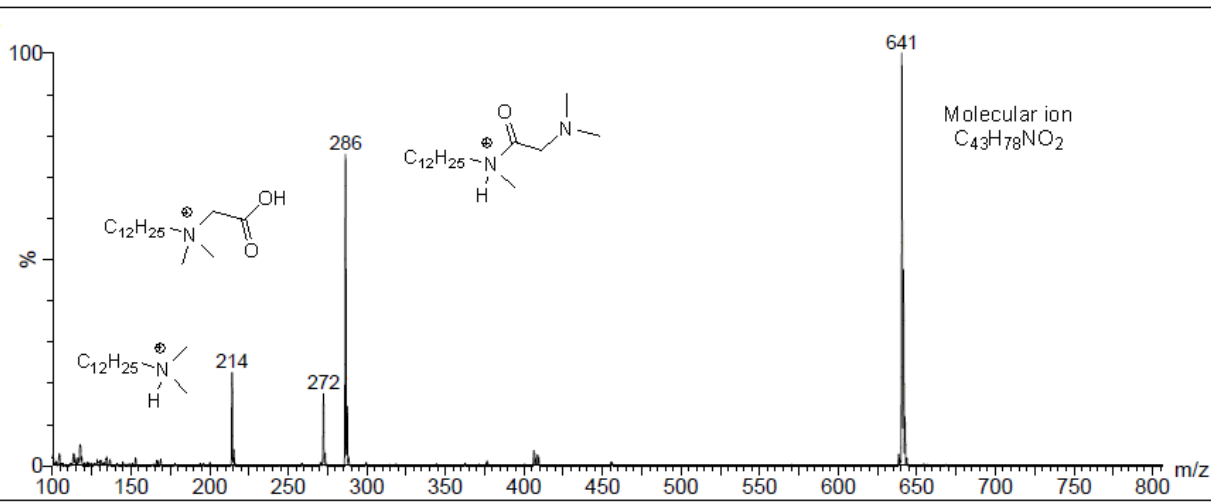
Figure 6. ESI-MS spectrum of conjugate 13